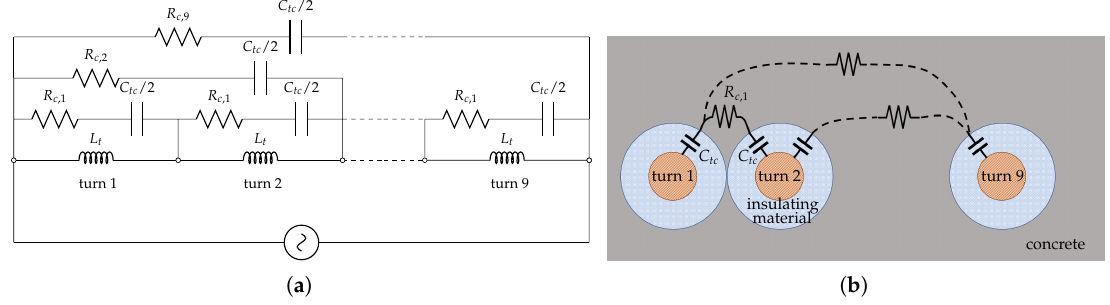
Figure 25. Electric circuit exemplification of the embedded coil. Electric circuit representation ( a ); model detail of the circuit interpretation ( b